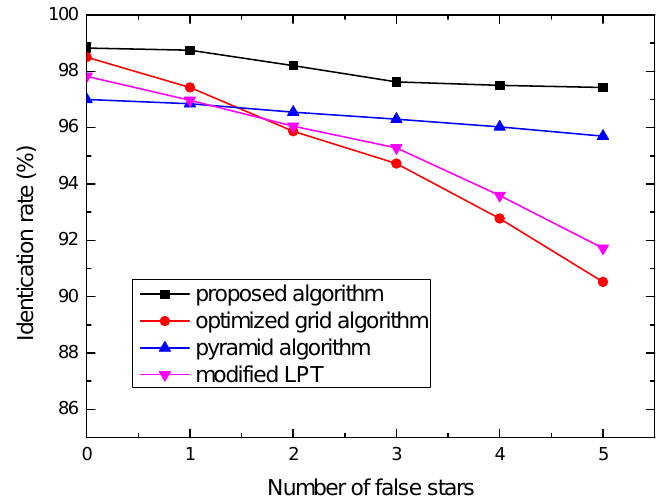
Figure 6. Identification rate versus number of false